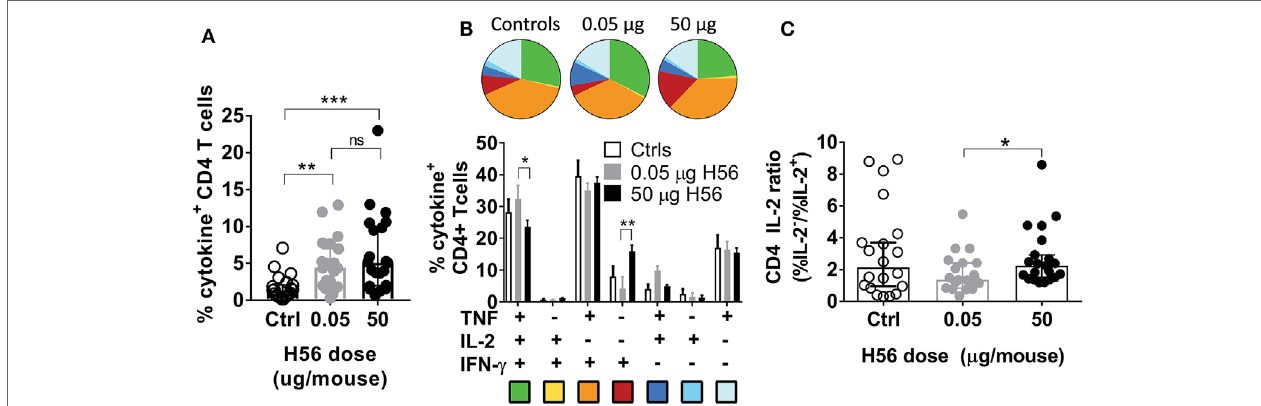
FigUre 3 | Non-protective, high dose post-exposure vaccination is associated with a more differentiated T cell response. One week post the final vaccination in the post-exposure model, mice were immunized with saline (controls, open bars/symbols), a low (0.05 µg, gray bars/symbols) or high (50 µg, filled black bars/symbols) dose of H56, and were assessed for vaccine-specific immune responses in the lung. (a) The proportion of lung CD4 T cells specific for H56 determined by intracellular cytokine stain (producing any cytokine of IFN- γ , TNF, IL-2, or IL-17A) after stimulation in vitro with H56 with media control background subtracted. Symbols, individual mice; bar, mean ± 95% CI; ** p < 0.01, *** p < 0.001 by one-way ANOVA (Kruskall–Wallis)/Dunn’s posttest for multiple comparisons between all groups. (B) Boolean analysis of the same data from panel (a) , showing the proportion of lung CD4 T cells producing any combination of the cytokines IFN- γ , TNF, and/or IL-2 after stimulation in vitro with H56. Background from media controls was subtracted. Pie charts and bars (mean ± SEM) represent the relative distribution of CD4 T cell subsets producing different cytokine combinations out of total cytokine-producing CD4 T cells (the total for each group equals 100%, relative values were chosen to eliminate variation in response-magnitude between experiments). Pie color-coding is indicated below the bar graph. * p < 0.05, ** p < 0.01 by a two-way ANOVA and Tukey’s multiple comparisons (the relative values were normally distributed). (c) From the data shown in panel (B) , we calculated the relative ability of vaccine specific CD4 T cells to produce IL-2. An IL-2 ratio (%IL-2 − /%IL-2 + ) was calculated for any CD4 T cell producing IFN- γ , TNF, or IL-2 after H56 stimulation—a higher ratio indicates lower IL-2 production (higher differentiation) of H56-specific T cells. Statistical difference between high and low dose vaccine groups was assessed Wilcoxon’s signed rank test. * p < 0.05. Data combined from seven experiments (see Materials and Methods for experiment